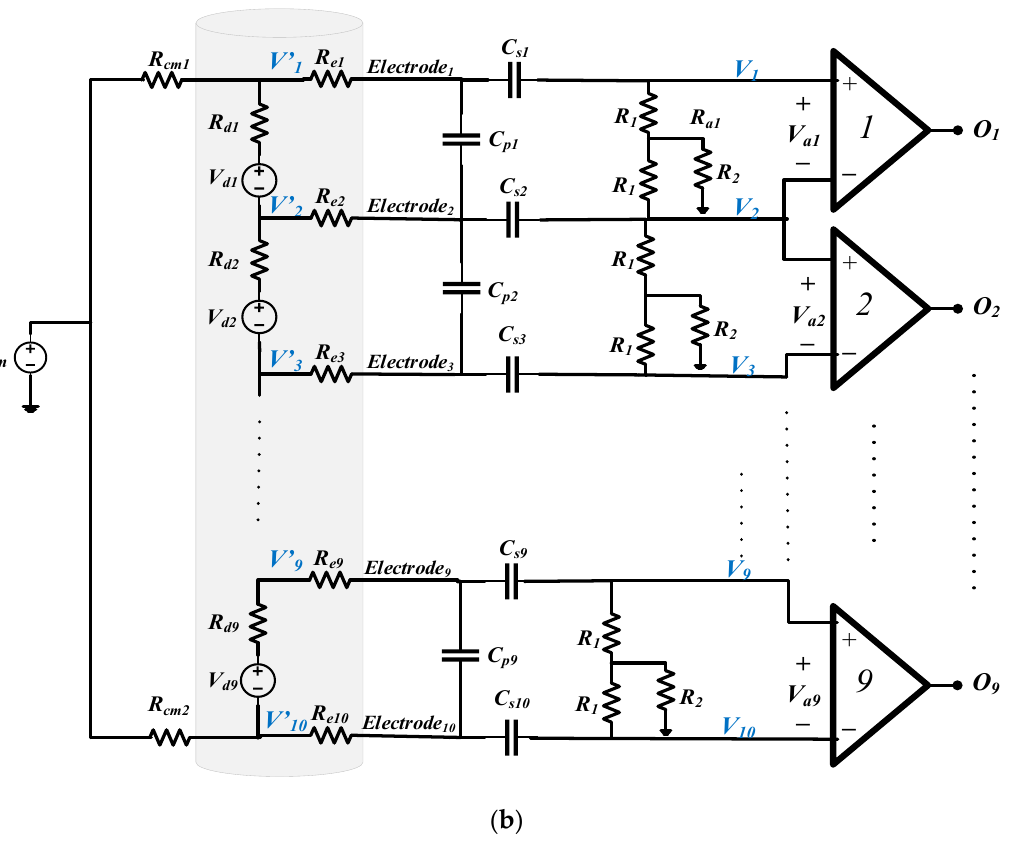
Figure 2. Front-end network with ( a ) ‘Type 1’ biasing arrangement and ( b ) ‘Type 2’ biasing arrange- ment.